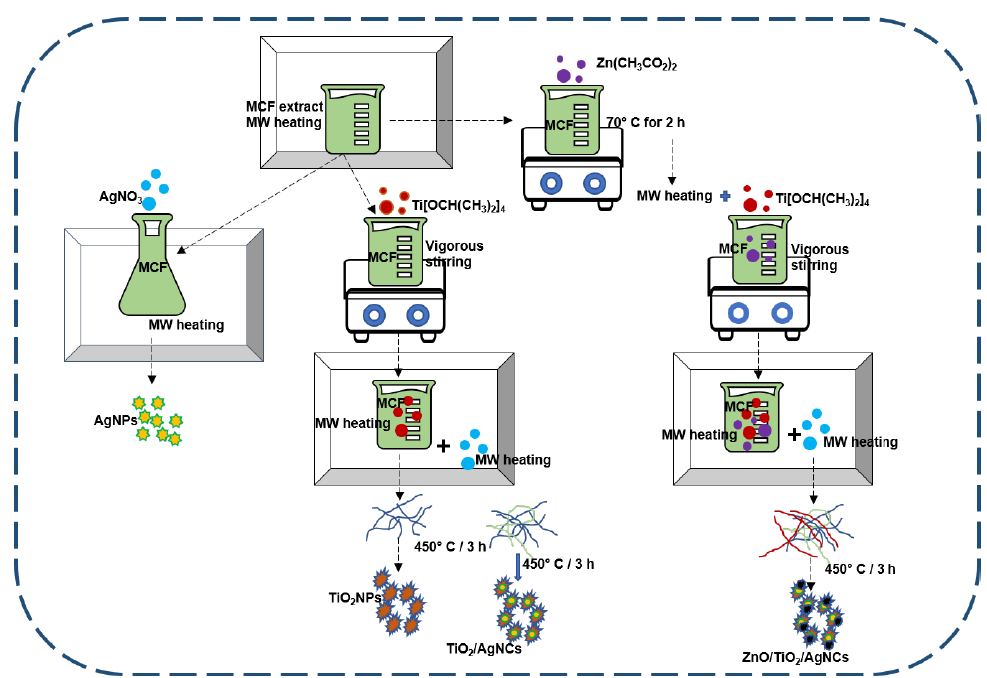
Figure 11. Schematic diagram of nanostructured materials synthesis using M. citrifolia extract via microwave-assistive techniques.